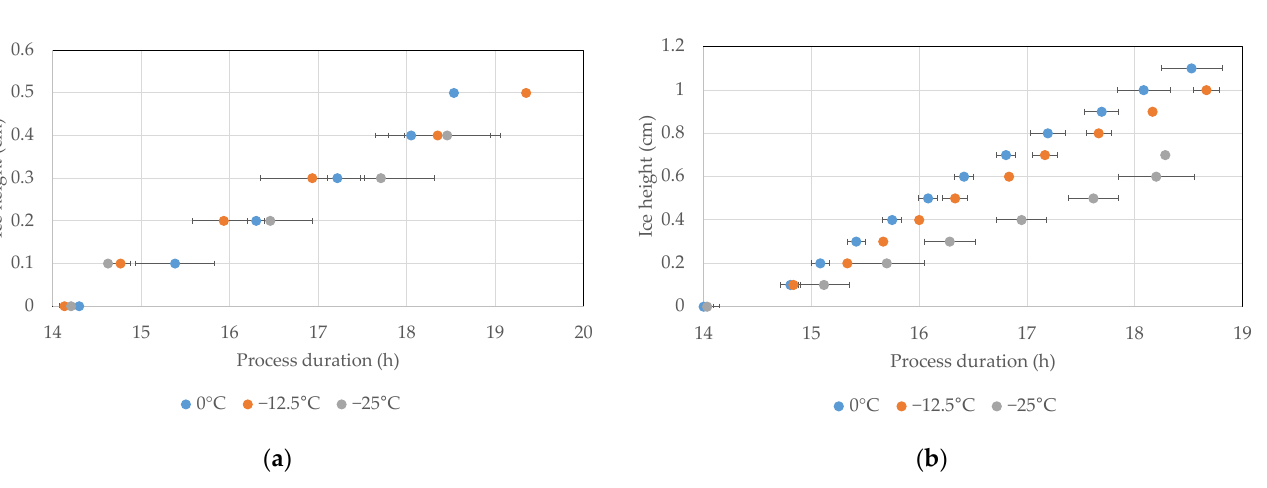
( b ) Figure 21. Ice height over time measured by an ice ruler for different solute concentrations of ( a ) saccharose and ( b ) mannitol. Next, the results for different solute concentrations are compared with the sublima- tion rate measured by MTM. In Figure 22, the sublimated ice mass and the ice height over the course of the process are shown. The progression of ice height and sublimated mass are comparable for all solute concentrations. At 100 g/L, MTM shows high deviations for both solutes. The increased batch heterogeneity leads to uncertainty in the number of vials that are sublimating, causing variance in the measurement. The course of the ice ruler is in good agreement with the sublimation rate. As soon as no increase in ice height is de- tectable, the primary drying phase is completed.